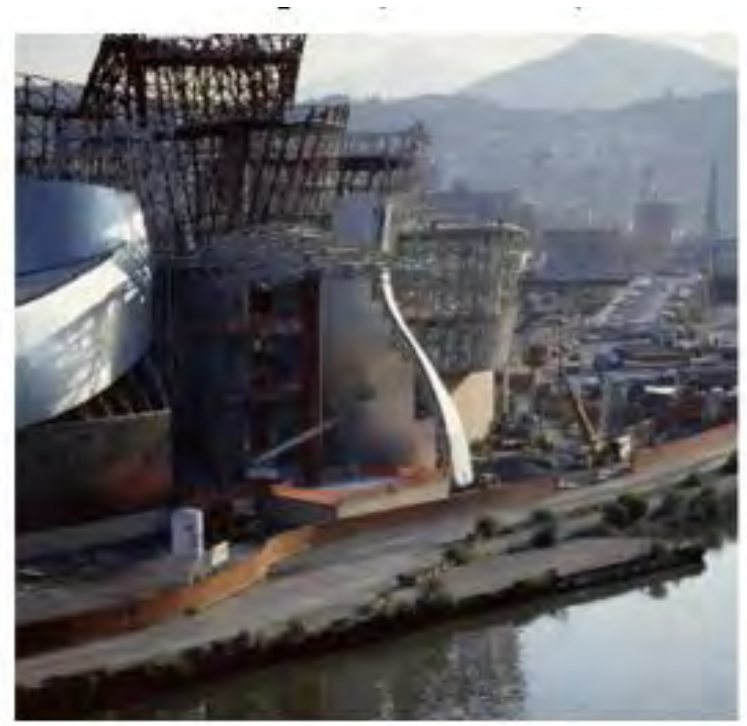
Figure 7. Guggenheim